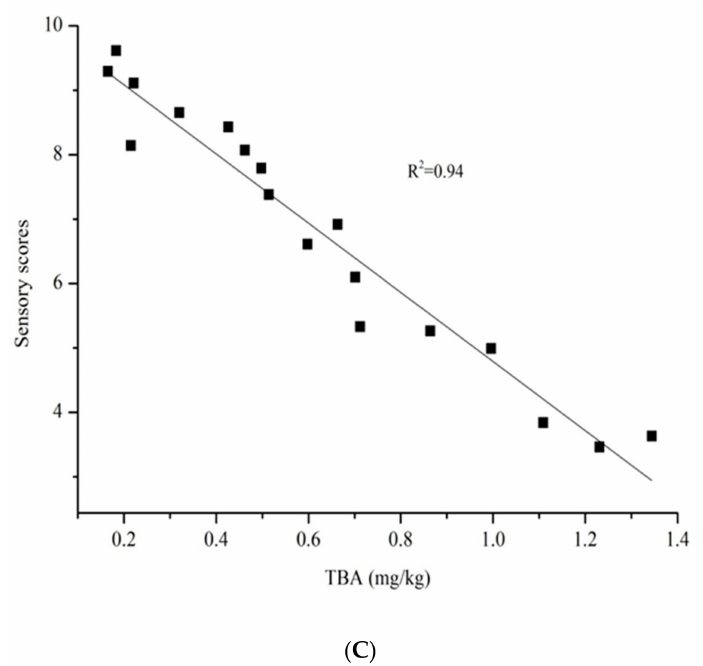
Figure 4. ( A ) Relationship between the overall assessment of sensory scores and TVC from the beginning of Spanish mackerel storage until the sensory rejection time. ( B ) Relationship between the overall assessment of sensory scores and TVB-N from the beginning of Spanish mackerel storage until the sensory rejection time. ( C ) Relationship between overall assessment of sensory scores and TBA from the beginning of Spanish mackerel storage until the sensory rejection time. Abbreviations—TVC, total viable count; TVB-N, total volatile base nitrogen; TBA, 2-thiobarbituric acid.